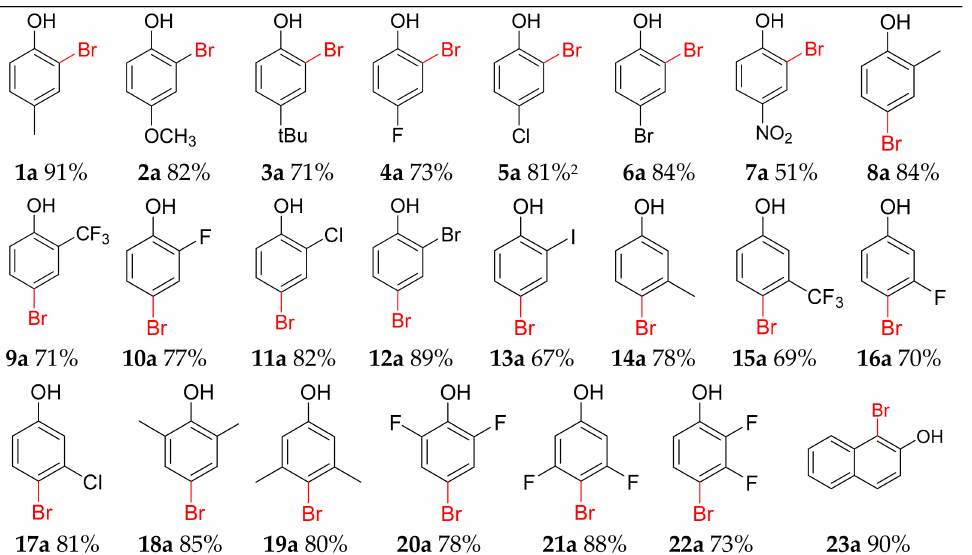
Figure 2. Scope of